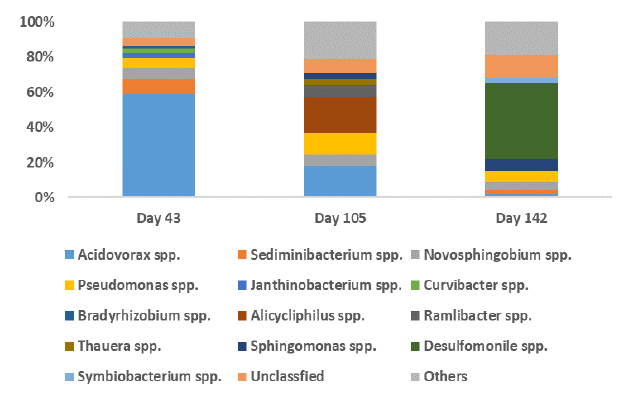
Figure 4. Community analysis of the genus-level bacteria present during the BDE-209 biodegradation in the clay/water slurry system.